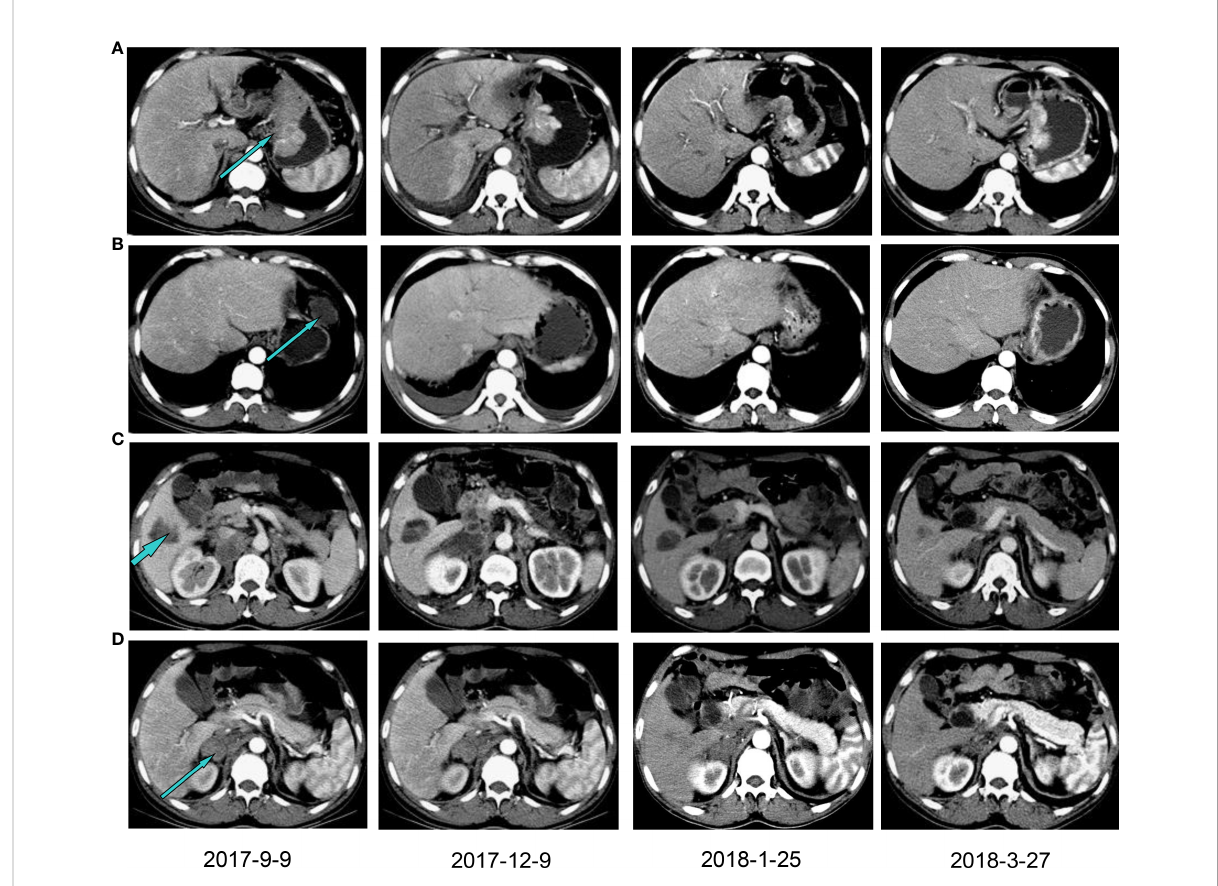
FIGURE 2 Computed tomography with contrast showing the patient ’ s lesions before and after PD-1 inhibitor treatment. The lesions in lesser gastric curvature (A) , left front of the gastric body (B) , right lobe of the liver (C) and right adrenal (D) . Patients were treated with a PD-1 inhibitor from December 2017.